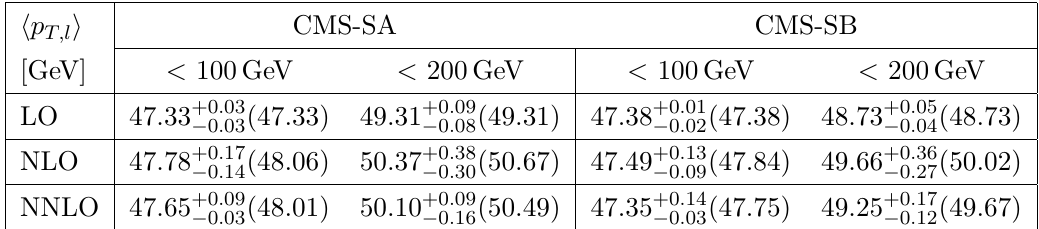
Table 1 . Average transverse momentum of the charged lepton within the two fiducial regions at various orders in QCD in the 5FS for LHC 13 TeV. Scale variations are evaluated by taking envelop of results with 9 scale choices. Numbers in parenthesis correspond to predictions without including QCD corrections in decay of top